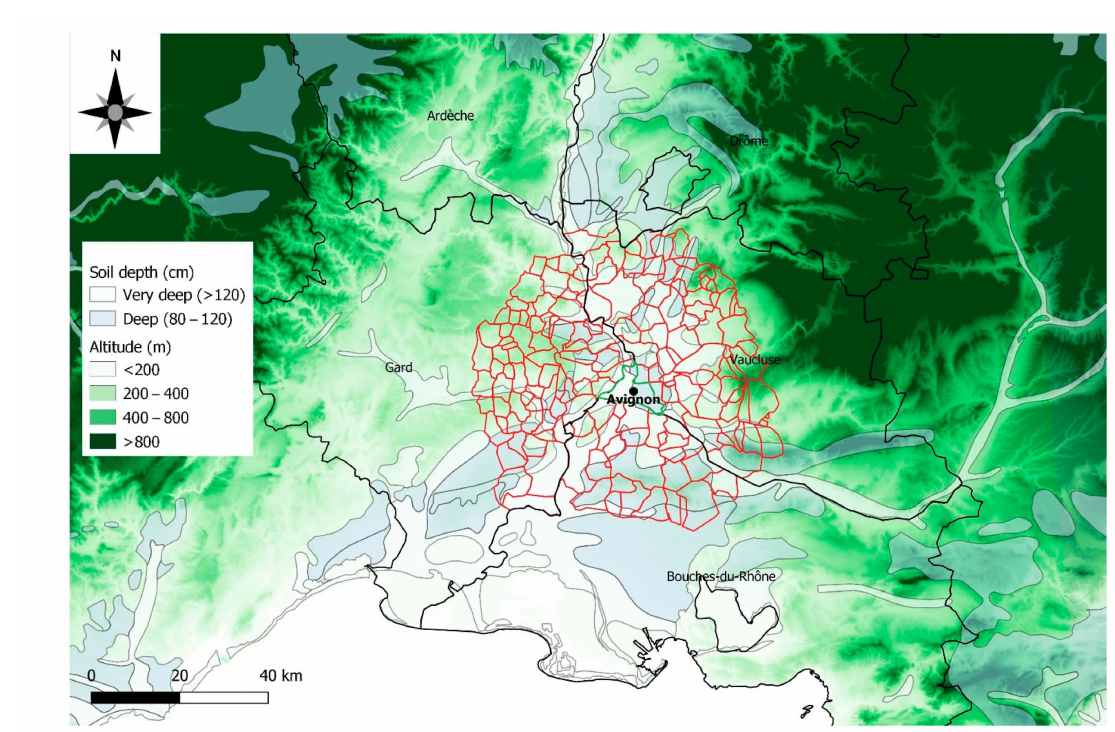
Figure 2. Location of the deep (80–120 cm) and very deep (>120 cm) soils in the foodshed area (in red), and in the surrounding areas of the different departments. The rest of the area is covered by soils with a shallow (0–40 cm) or moderate (40–80 cm) depth. The map also shows the altitudes in four categories (<200, 200–400, 400–800 and >800 m above sea level). Note that deep soils are usually located in low-altitude